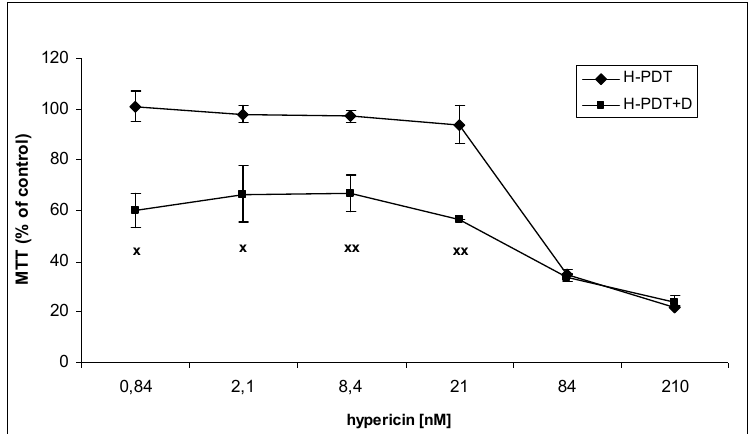
Figure 4. The effect of PDT with hypericin (H-PDT) and its combination with 17-DMAG (H-PDT + D) on the metabolic activity of SKBR-3 cells evaluated by MTT assay. The cells were treated for 24 h with single hypericin (0.84–210 nM) or combined with 17-DMAG (5 nM) under dark conditions, photoactivated and consequently analyzed 48 h later.